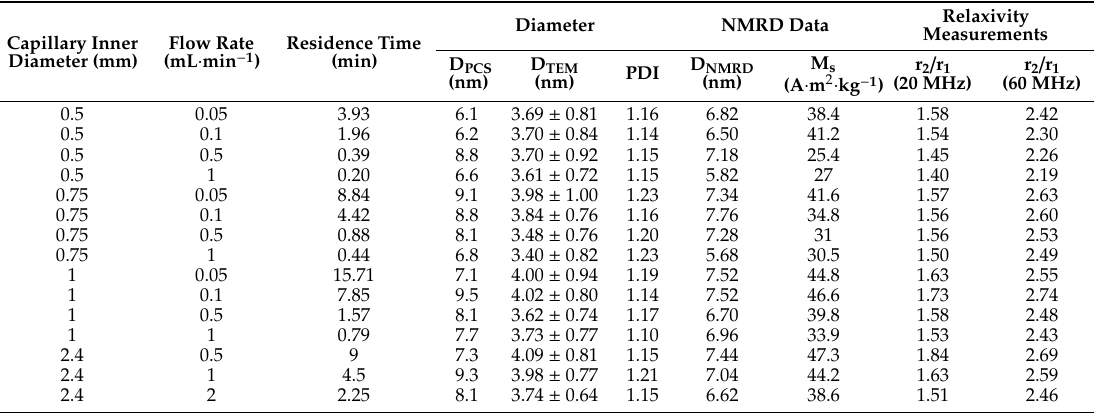
Table 2. Summary of the experimental parameters and results obtained by PCS, TEM and relaxometry for the study of flow parameters